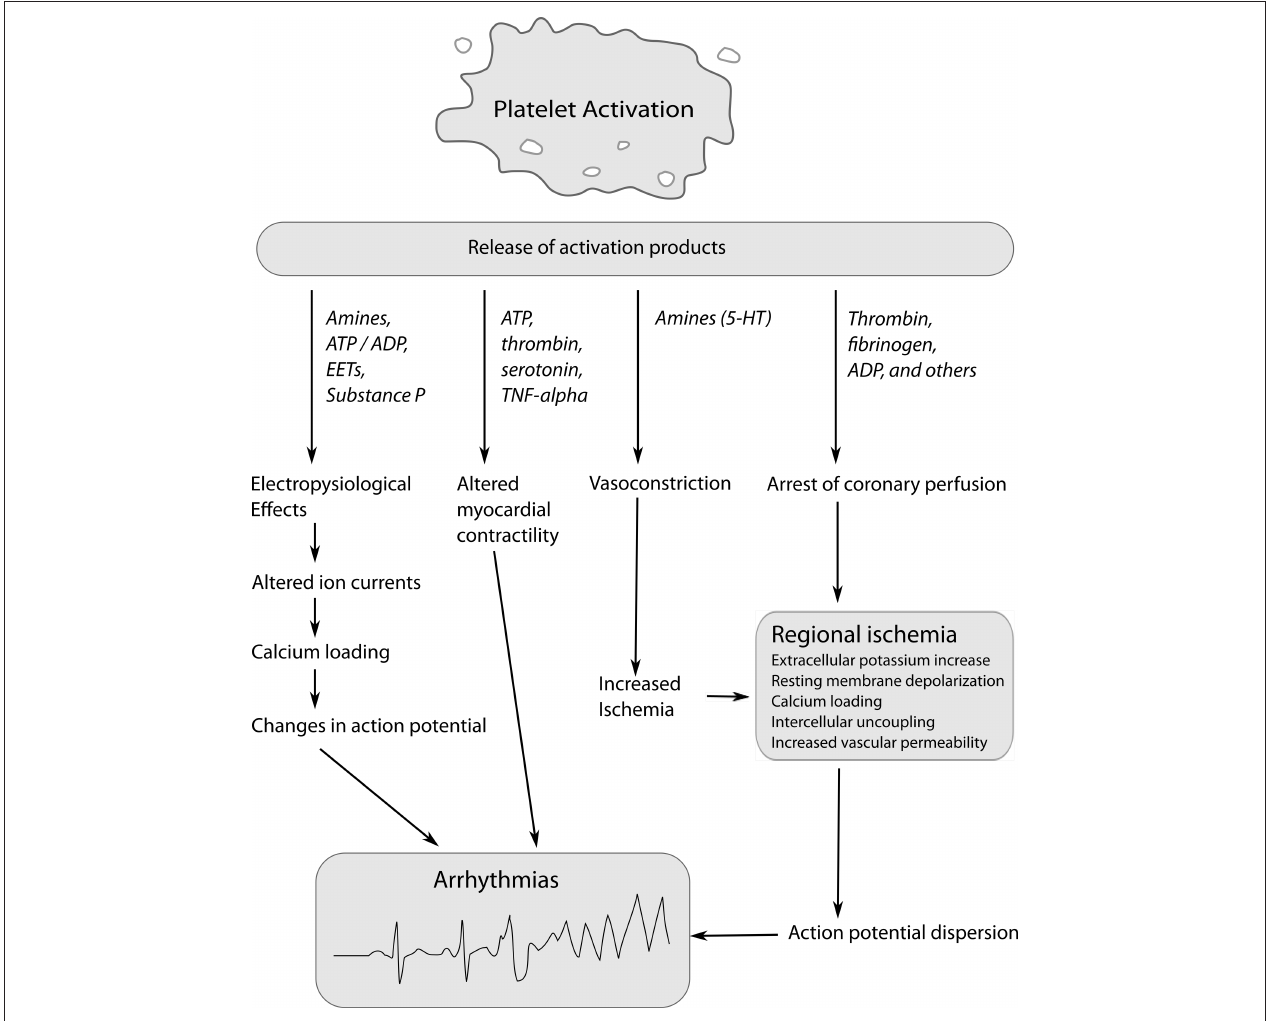
Figure 1 | Mechanisms by which platelet activation and release of platelet products could induce arrhythmias during ischemia. ADP/ATP, adenosine diphosphate, adenosine triphosphate; EETs, epoxyeicosatrienoic acids; 5-HT, 5-hydroxytryptamine (serotonin); TNF- α , tumor necrosis factor- α